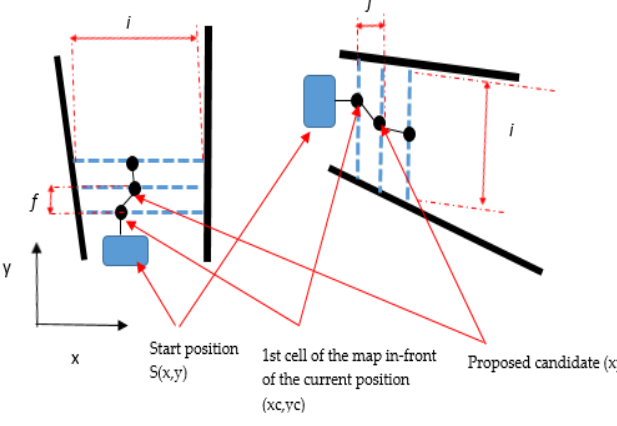
Figure 2. Basics of the Laser Simulator (LS) principle.